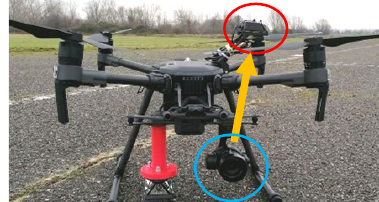
Figure 2. The quadcopter DJI Matrice 210 v2 used for the tests. The blue circle marks the position of the camera, the DJI X5S, the red circle highlights the GNSS antenna placement. The yellow arrow denotes the level arm offset between the camera and the antenna.